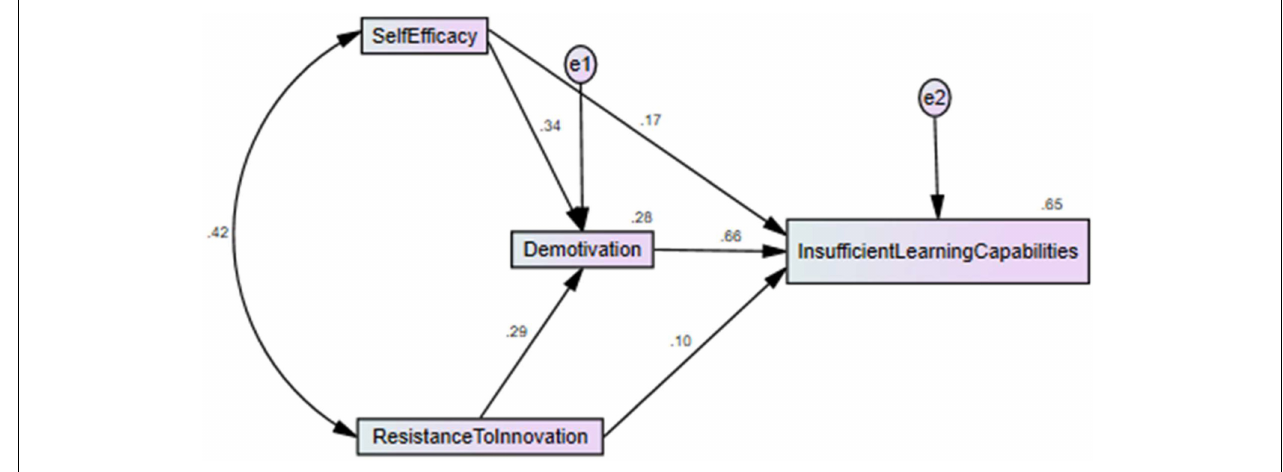
FIGURE 3 | Structural model assessment.